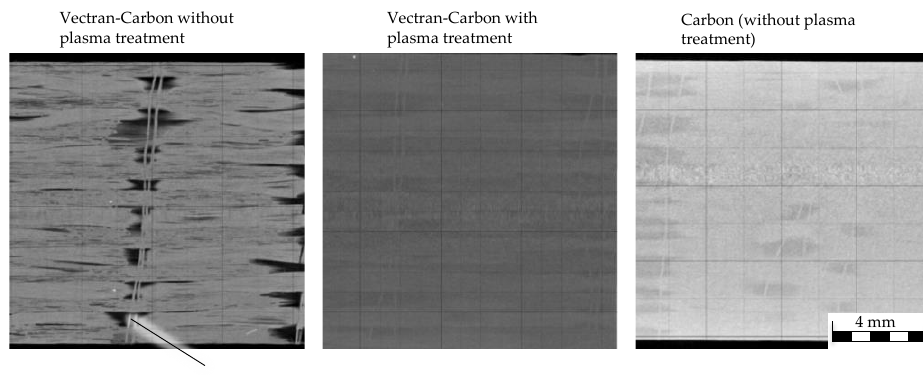
Figure 7. CT scans of Vectran-Carbon composite and Carbon composites. Untreated Vectran-Carbon shows non-impregnated areas. Whereas plasma-treated Vectran-Carbon shows an impregnation comparable to that of